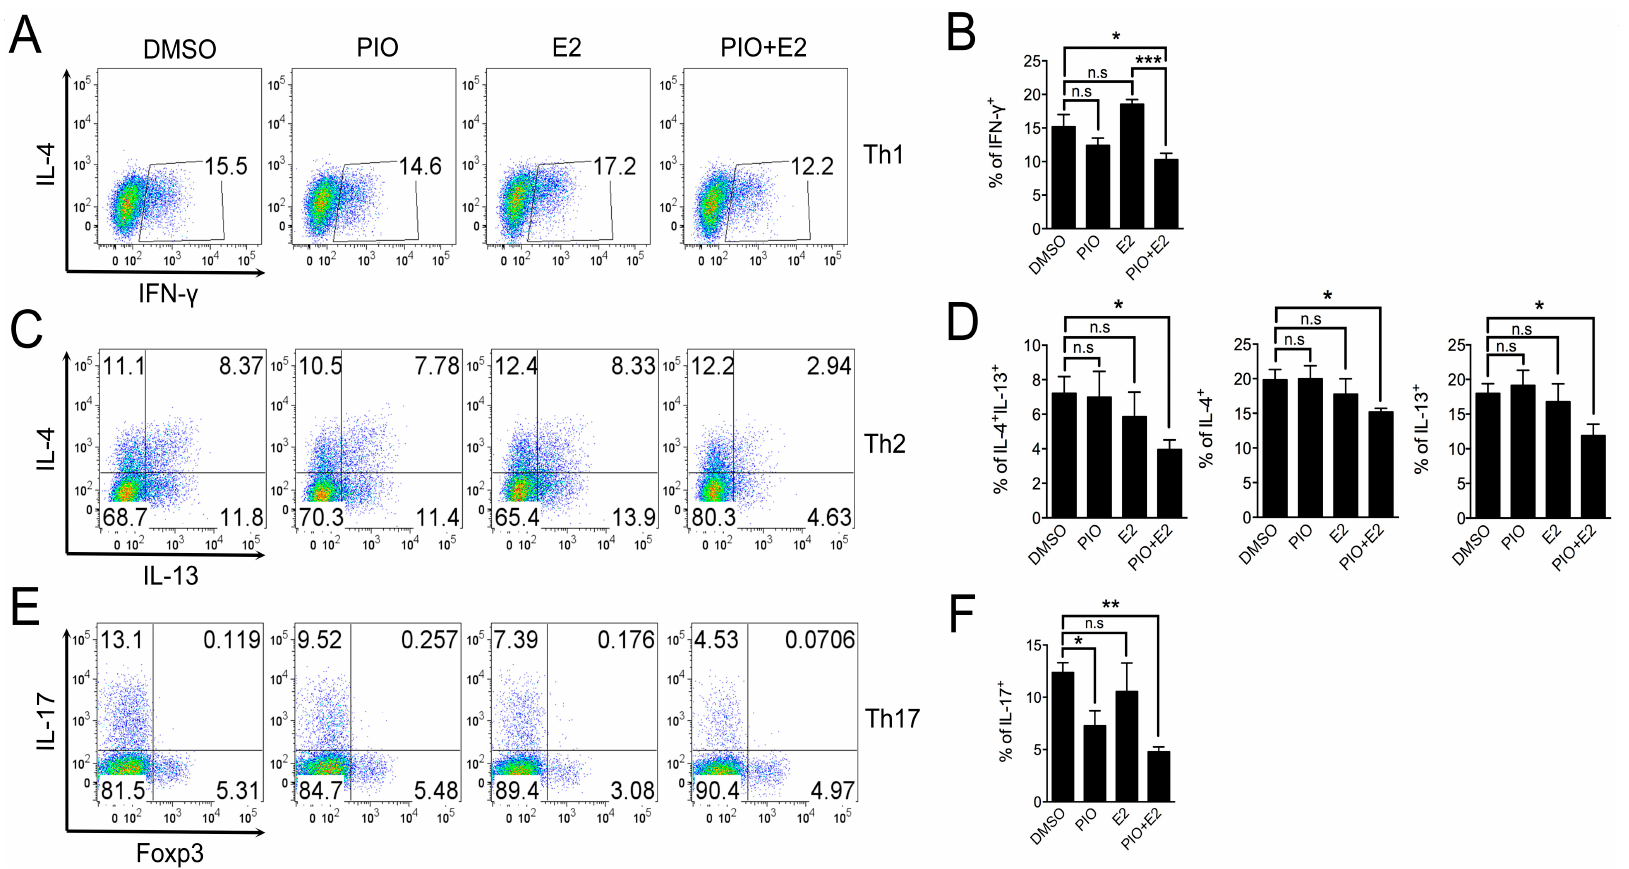
Figure 5. Pioglitazone and estradiol co-treatment inhibits Th1, Th2, and Th17 differentiation in male T cells. CD62L high CD44 low naïve T cells were purified by magnetic-activated cell sorting (MACS) from the spleens of six- to eight-week-old male wild-type C57BL/6 mice and were differentiated into Th1 and Th17 cells for three days and Th2 cells for five days under lineage-specific skewing conditions with DMSO, pioglitazone (20 μ M), E2 (5 nM), or pioglitazone (20 μ M) + E2 (5 nM). The proportions of IFN- γ –producing cells in Th1 differentiation ( A , B ); IL-4– and IL-13–expressing cells in Th2 differentiation ( C , D ) and IL-17A–secreting cells in Th17 differentiation ( E , F ) were determined by flow cytometry and depicted as the dot plots. Values represent mean ± SEM ( n = 4~5). * p < 0.05, ** p < 0.01, *** p < 0.001; n.s: non-significant.